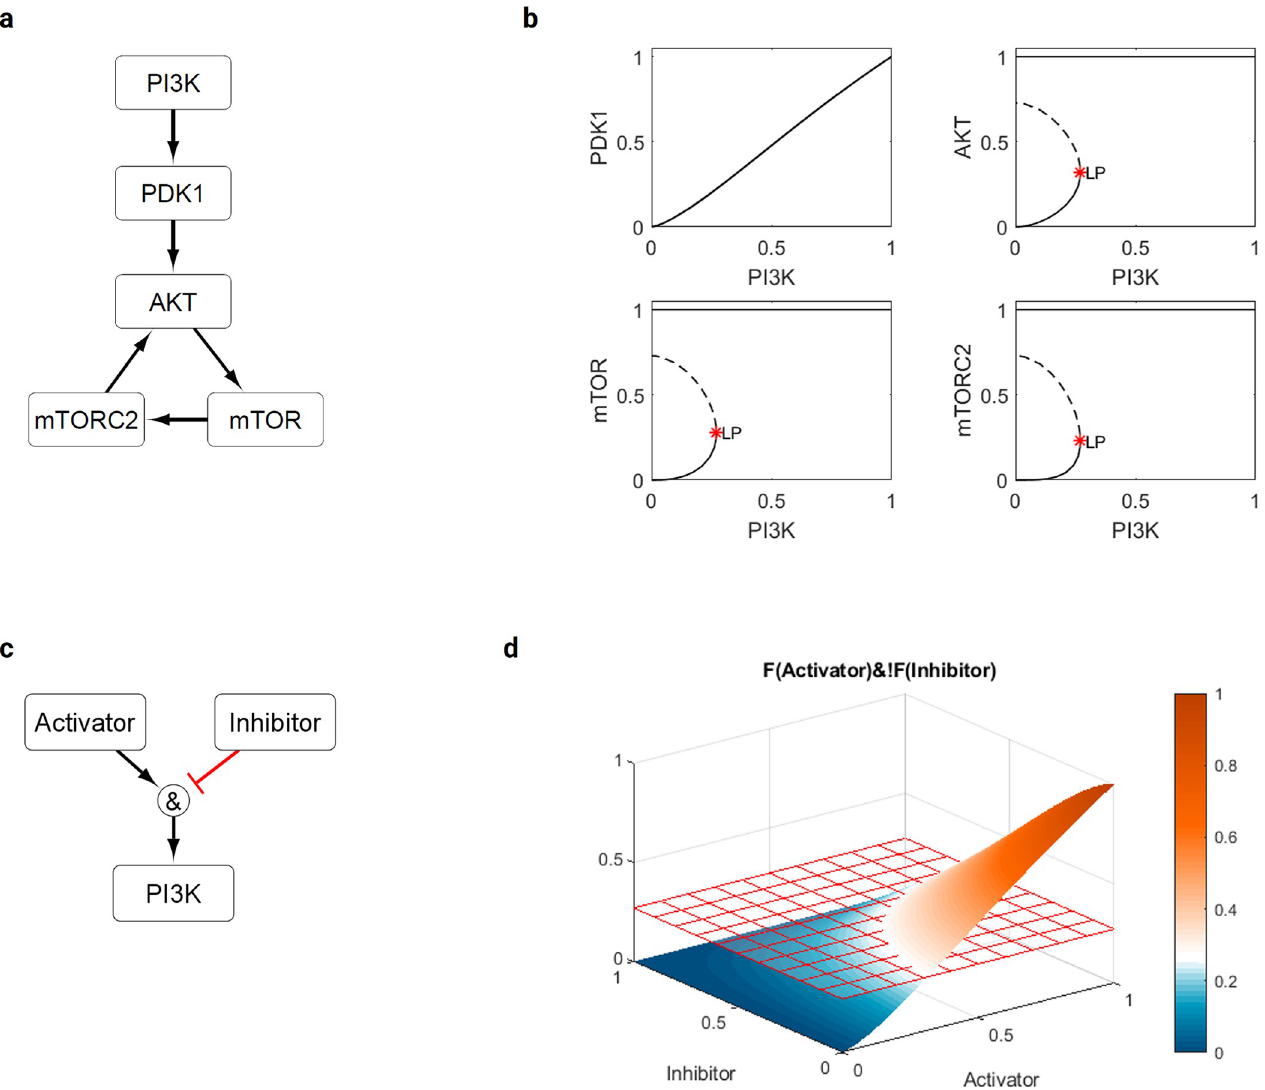
Fig 5. Focus on the PI3K/AKT/mTOR signaling sub-network structure. a) Simplified network diagram showing the positive feedback loop for AKT activation with PI3K serving as an input. b) MatCont bifurcation analysis showing the stable (solid lines) and unstable (dashed lines) steady-state solutions for each downstream species in the model shown in (a) for different levels of PI3K input. While there is no bifurcation for PDK1, the other three species in the network (AKT, mTOR, and mTORC2) exhibit a limit point bifurcation (LP), indicated by a star, detected at a level of PI3K = 0.27083. c) Simplified network diagram showing an activator and inhibitor pair interacting via an AND gate to activate PI3K. d) Surface plot showing the steady-state activation level of PI3K for different levels of an upstream activator and inhibitor pair. The threshold for saturation of the downstream species in the positive feedback loop is shown as a grid. Increasing the level of inhibitor prevents PI3K from crossing this